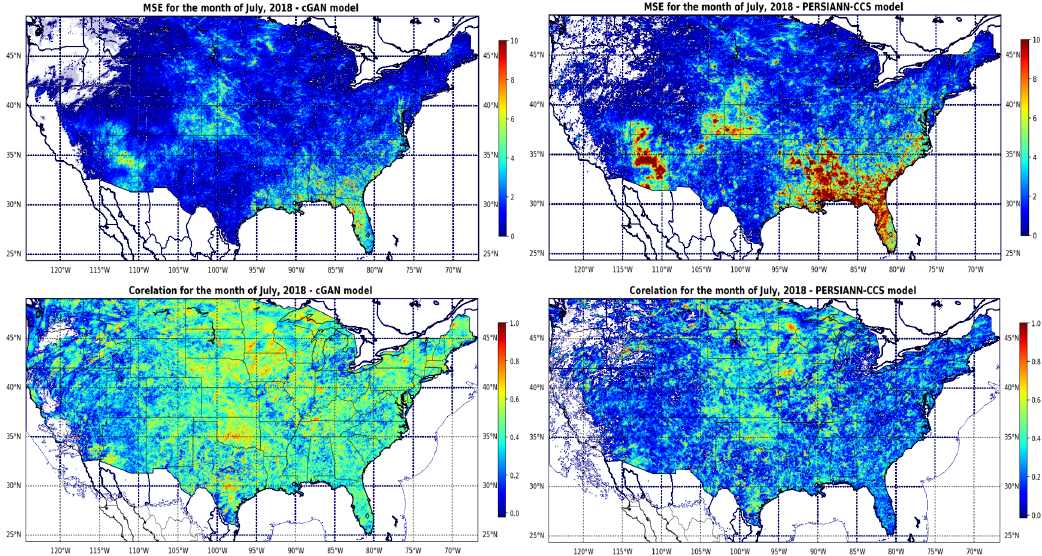
Figure 8. The Correlation and mean square error (MSE) values (mm h − 1 ) 2 for the cGAN and PERSIANN-CCS model over the CONUS and during the validation period (month of July